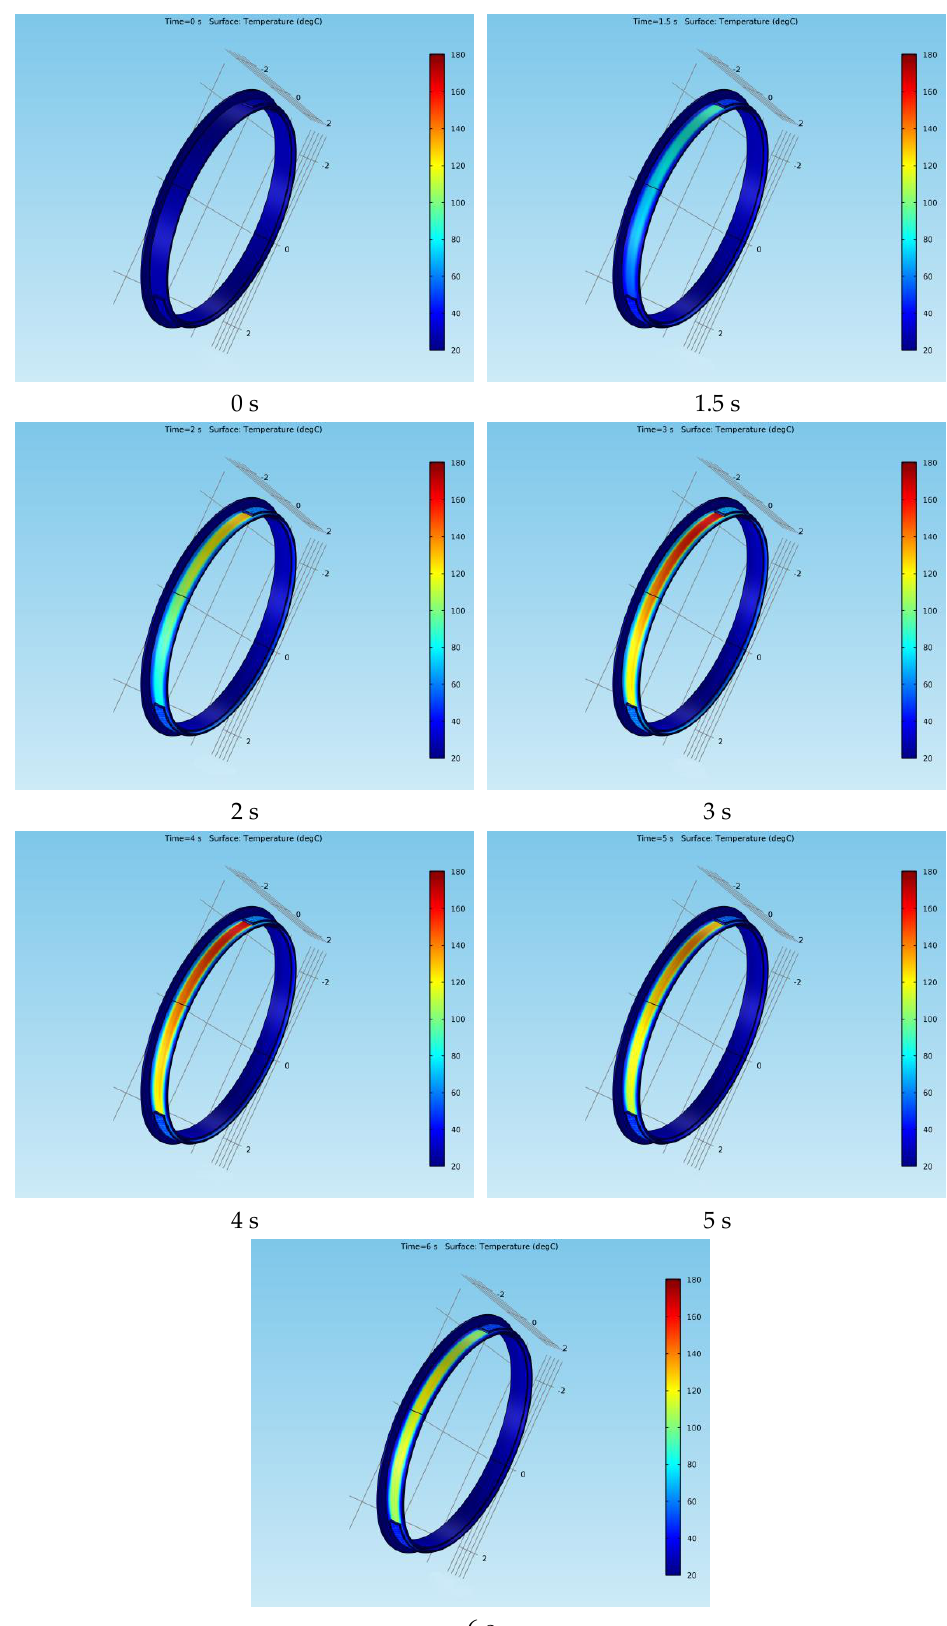
Figure 20. Surface temperature variation in position for the drum-and-shoe brake